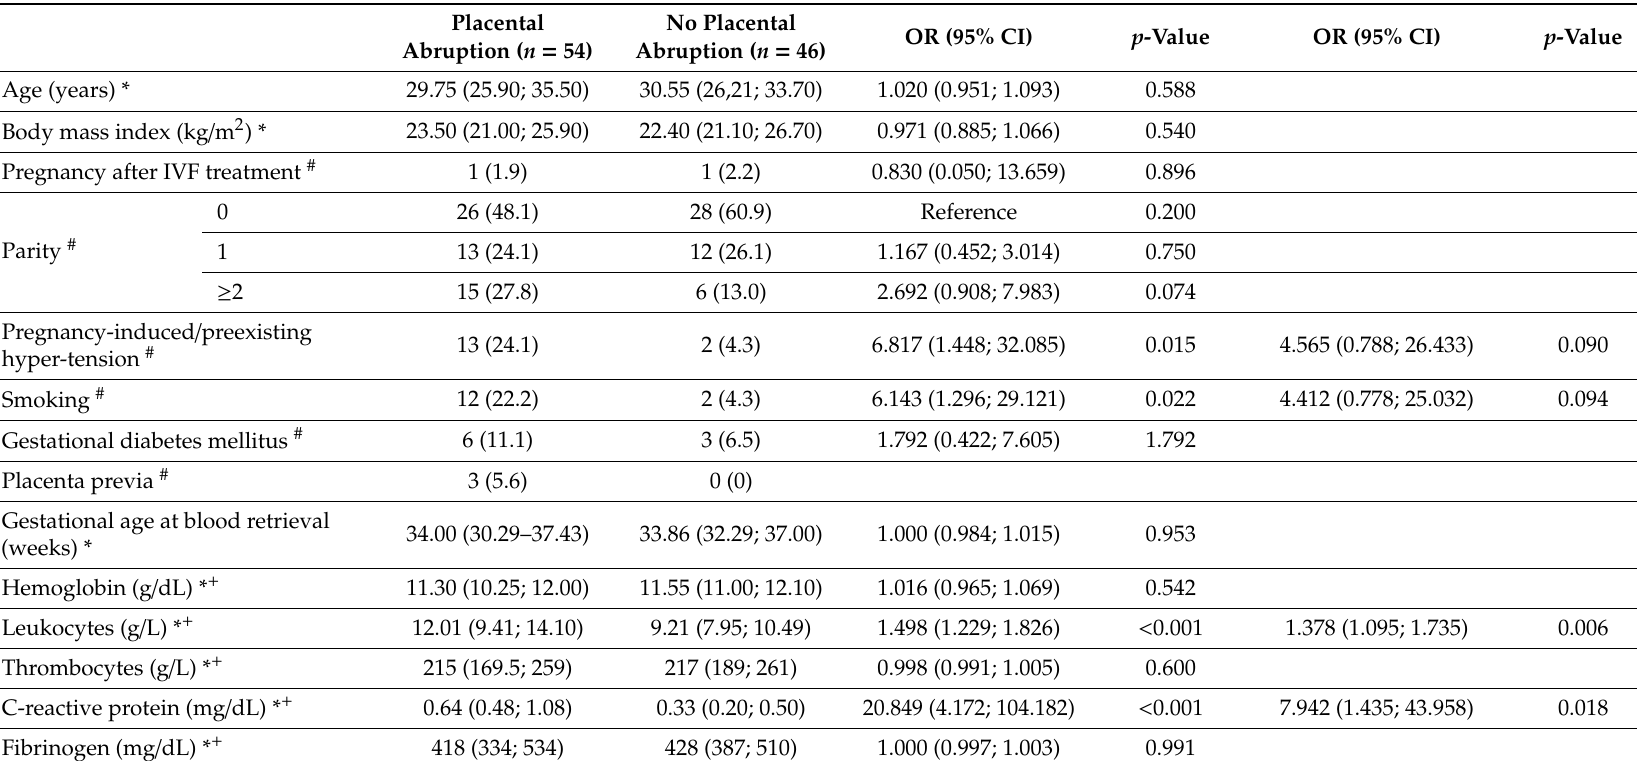
Table 5. Non-bleeding women with placental abruption and healthy patients after cytomegalovirus infection in the first trimester: comparison of basic patient characteristics and laboratory